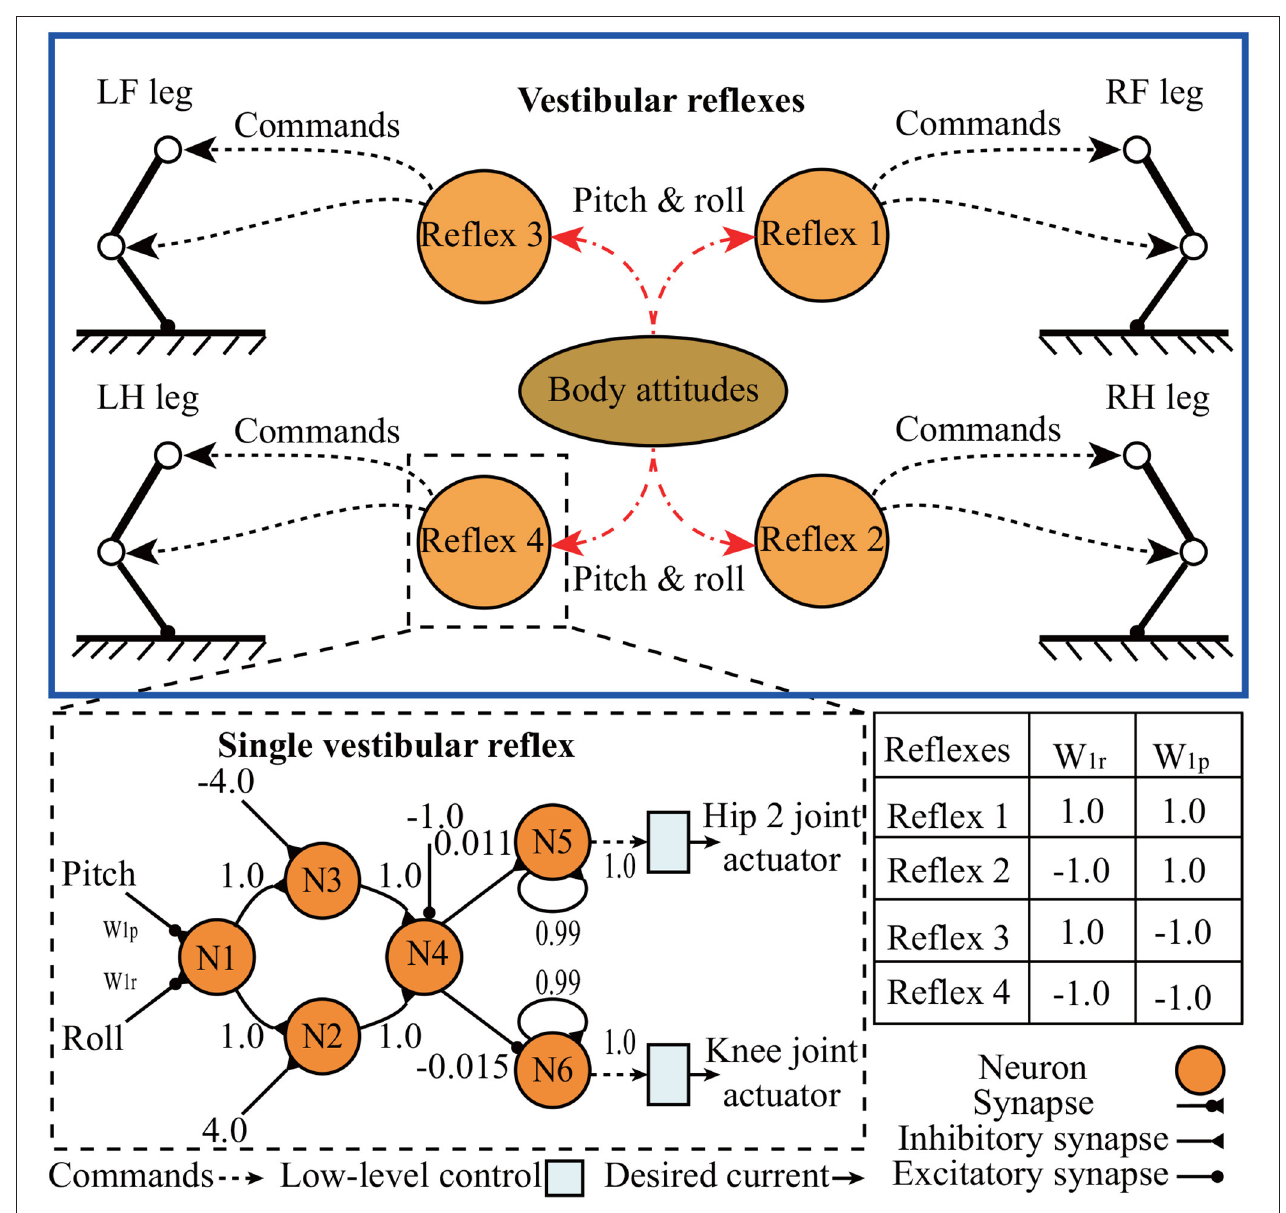
FIGURE 7 | Schematic of vestibular reflex control mechanism. The weights of the neural reflex network are set